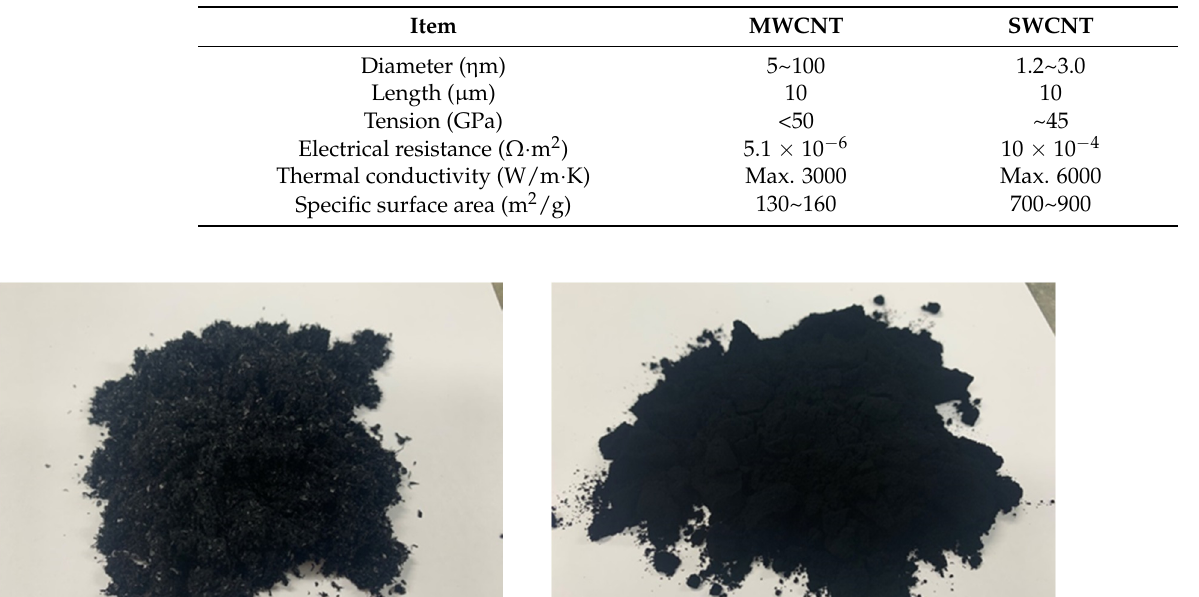
Table 2. Physical properties of carbon nanotubes (CNTs).